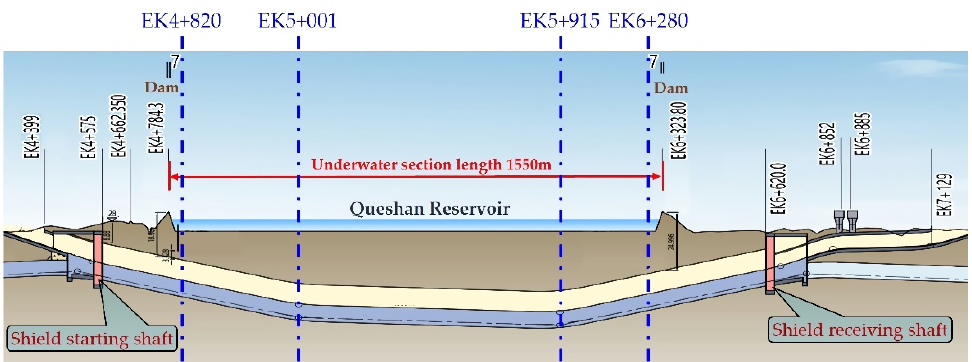
Figure 14. The longitudinal section view of the right shield tunnel.